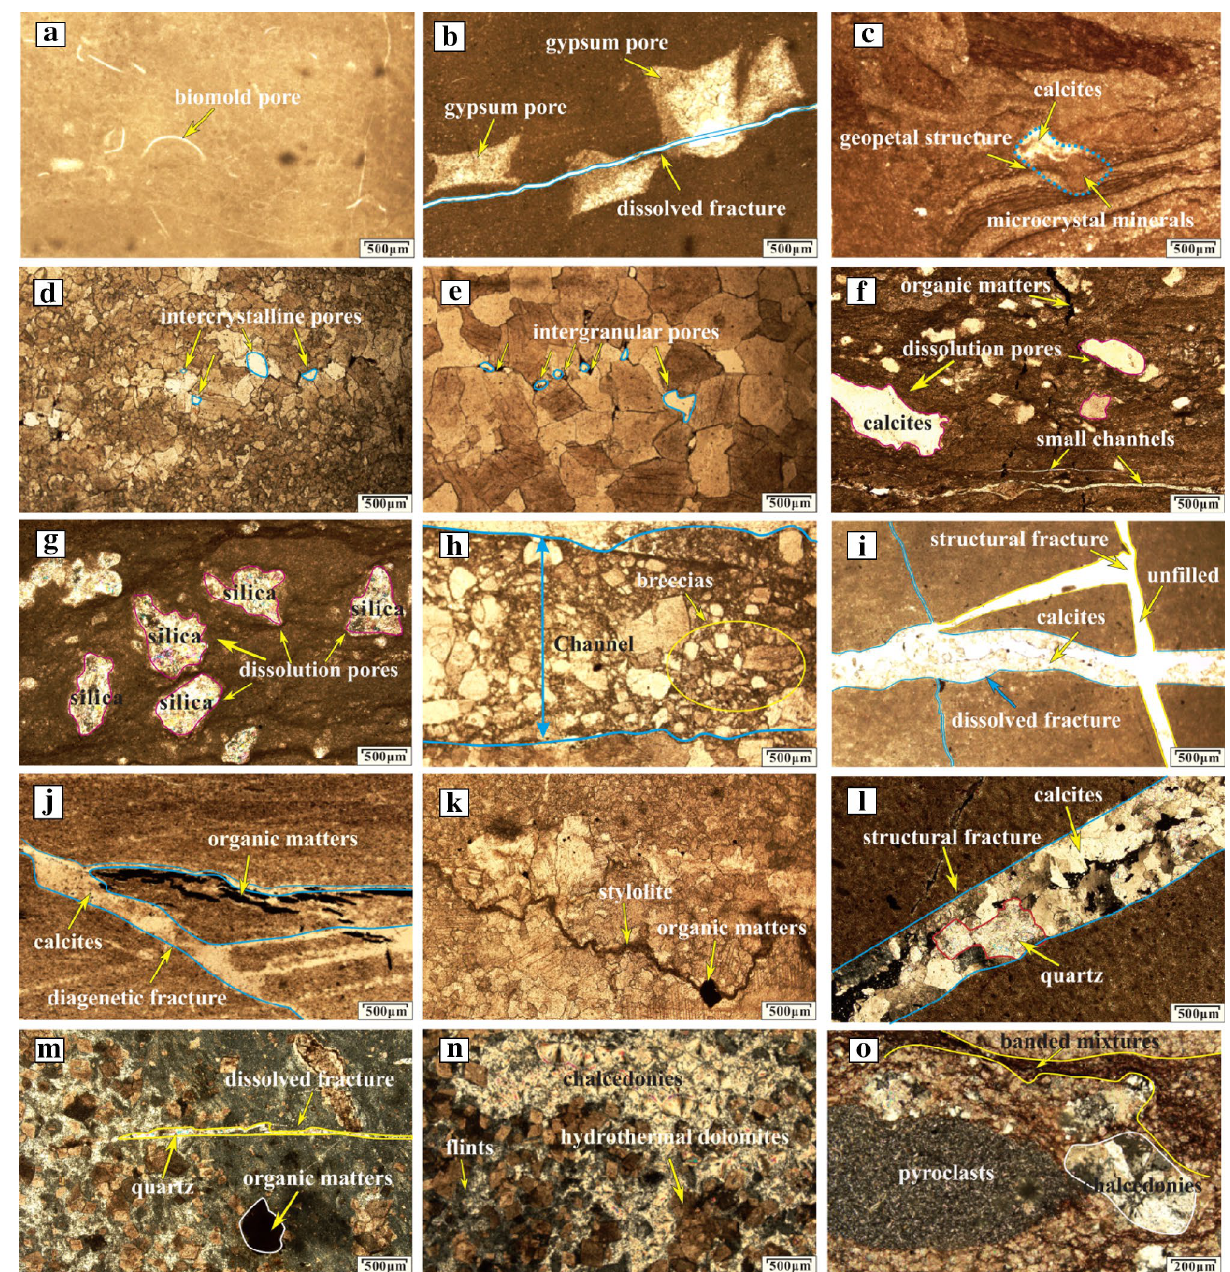
Figure 5. Microphotographs of the Ordovician carbonate pores and fillings: ( a ) Biomold pores full-filled with calcites, Well H8, 1654.07 m; ( b ) Gypsum pores and dissolved fractures full-filled with calcites, Well H3, 1545.15 m; ( c ) Geopetal structure: the upper part is filled with bright calcites and the lower part is filled with dark materials, Well H6, 1478.35 m; ( d ) Intercrystalline pores full-filled with calcites, Well F1, 870.05 m; ( e ) Intergranular pores full-filled with calcites, Well F2, 1103.57 m; ( f ) Dissolution pores, fractures and small channels filled with calcites or organic matters, Well H1, 508.13 m; ( g ) Dissolution pores filled with silica or organic matters, Well H4, 1070.85 m; ( h ) Channels filled with karst breccias, Well H1, 660.45 m; ( i ) Tectonic fractures and dissolved fractures, Well F3, 1438.95 m; ( j ) dissolved fractures full-filled with calcites and organic matters, Well H1, 580.25 m; ( k ) Stylolites full-filled with organic matters, Well H2, 1120.67 m; ( l ) dissolved fractures semi-filled with quartzs and calcites, Well F1, 863.62 m; ( m ) Dissolution pores and fractures filled with thermal minerals, Well H5, 855.34 m; ( n ) Thermal minerals, Well H5, 913.67 m; ( o ) Thermal minerals, Well H5, 937.35